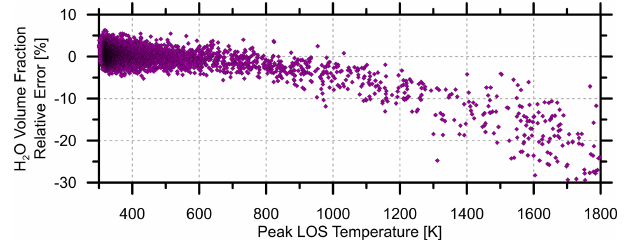
Figure A2. Relative error of H 2 O volume fraction results from sim- ulated measured data compared to peak LOS temperature for each result.